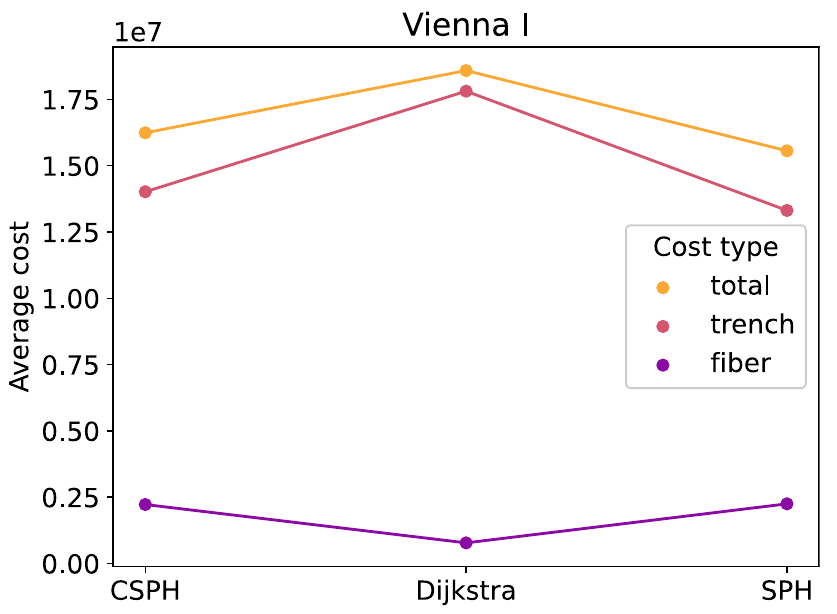
Fig 3. Vienna I cost type analysis. Different cost types (fiber, trench and total) for the CSPH, Dijkstra and SPH